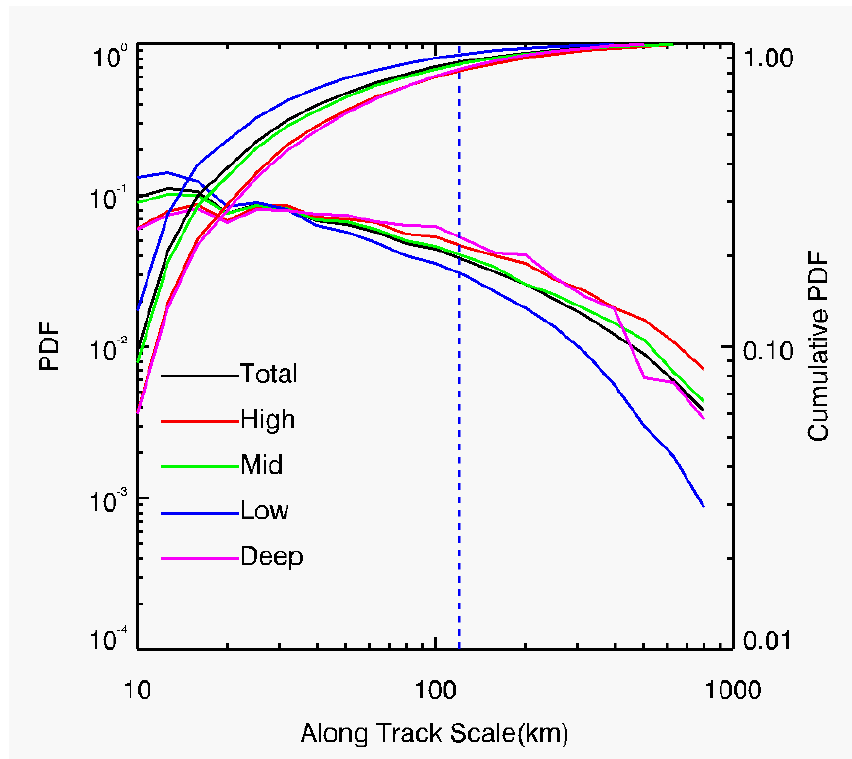
Figure 12. PDFs and cumulative PDFs of along-track horizontal scales for total, low-level, mid-level, high-level, and deep clouds.